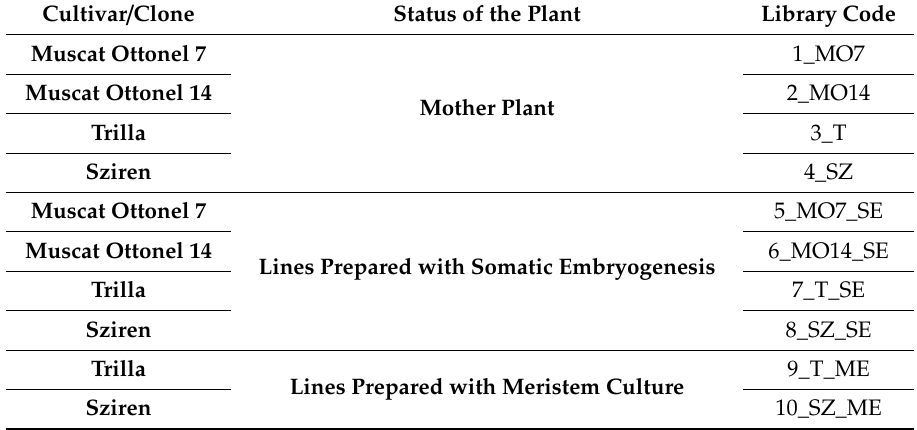
Table 1. Summary of the prepared small RNA HTS sequencing